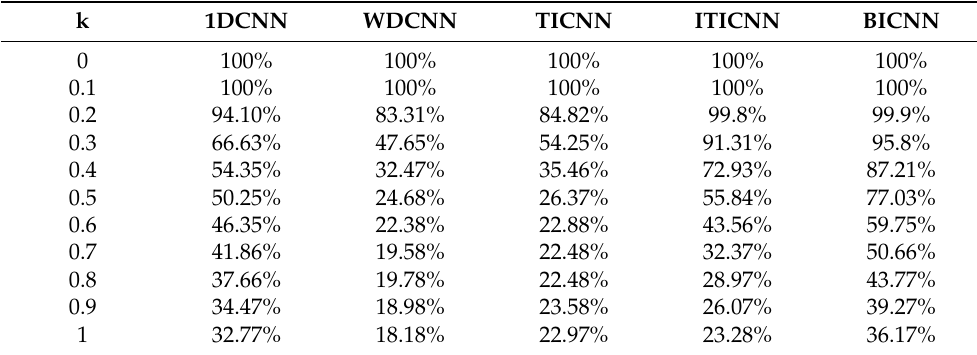
Table 5. Diagnosis accuracy of five neural network models in noise